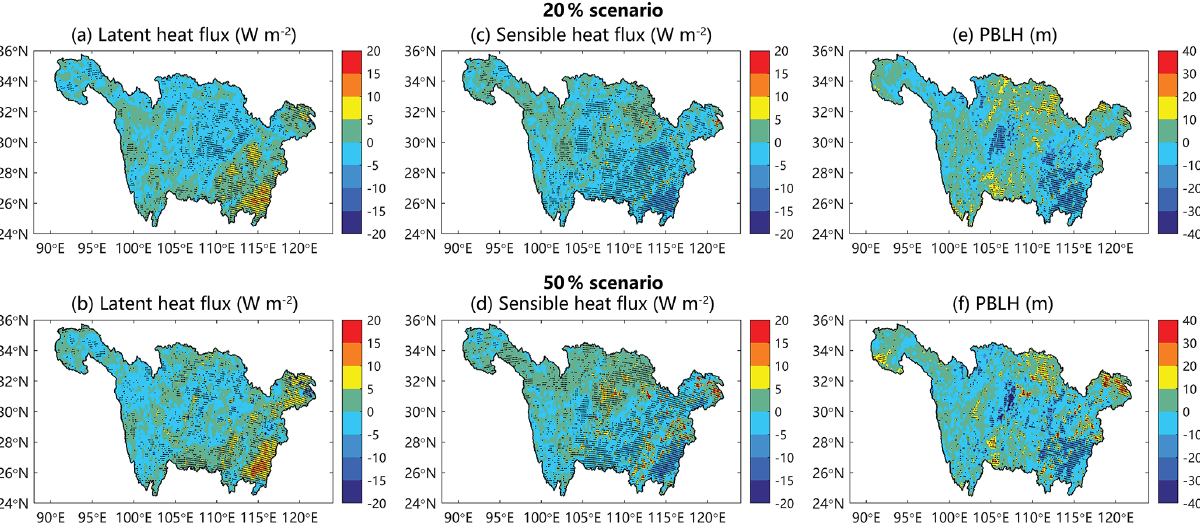
Figure 13. The changes in (a, b) latent heat flux (LHF, Wm − 2 ), (c, d) sensible heat flux (SHF, Wm − 2 ), and (e, f) planetary boundary layer height (PBLH, m) between the 20% scenario and the 2010 scenario and between the 50% scenario and the 2010 scenario. The stippled regions show statistical significance of the changes identified by the t test at a 5% significance level.